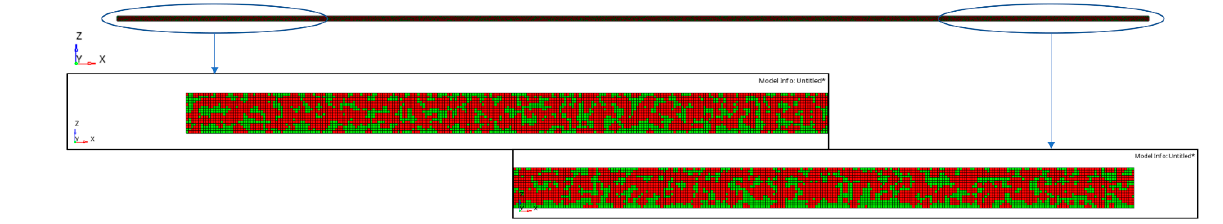
Figure 5. Graphical representation of RSP FE mesh in Altair Hyper Mesh